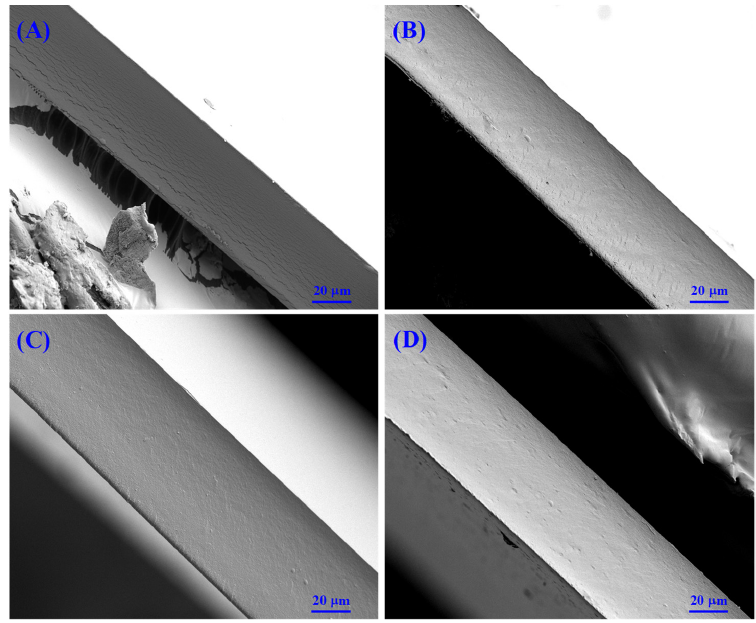
Figure 5. SEM micrographs on the cross-section of chitosan (CS) ( A ), p -coumaric acid-g-CS ( B ), caffeic acid-g-CS ( C ) and ferulic acid-g-CS ( D ) films.